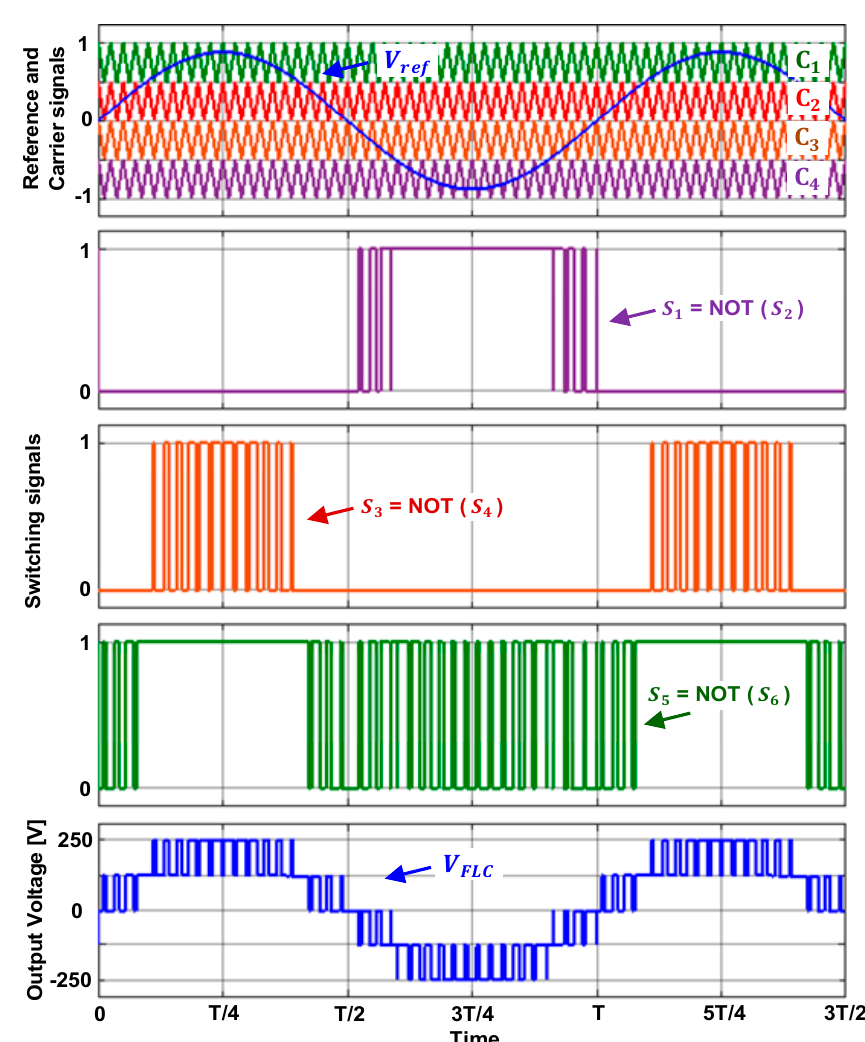
Figure 3. MPDPWM modulation strategy: reference and carrier signals, switching pattern and the resulting output voltage from the proposed SPFLC.